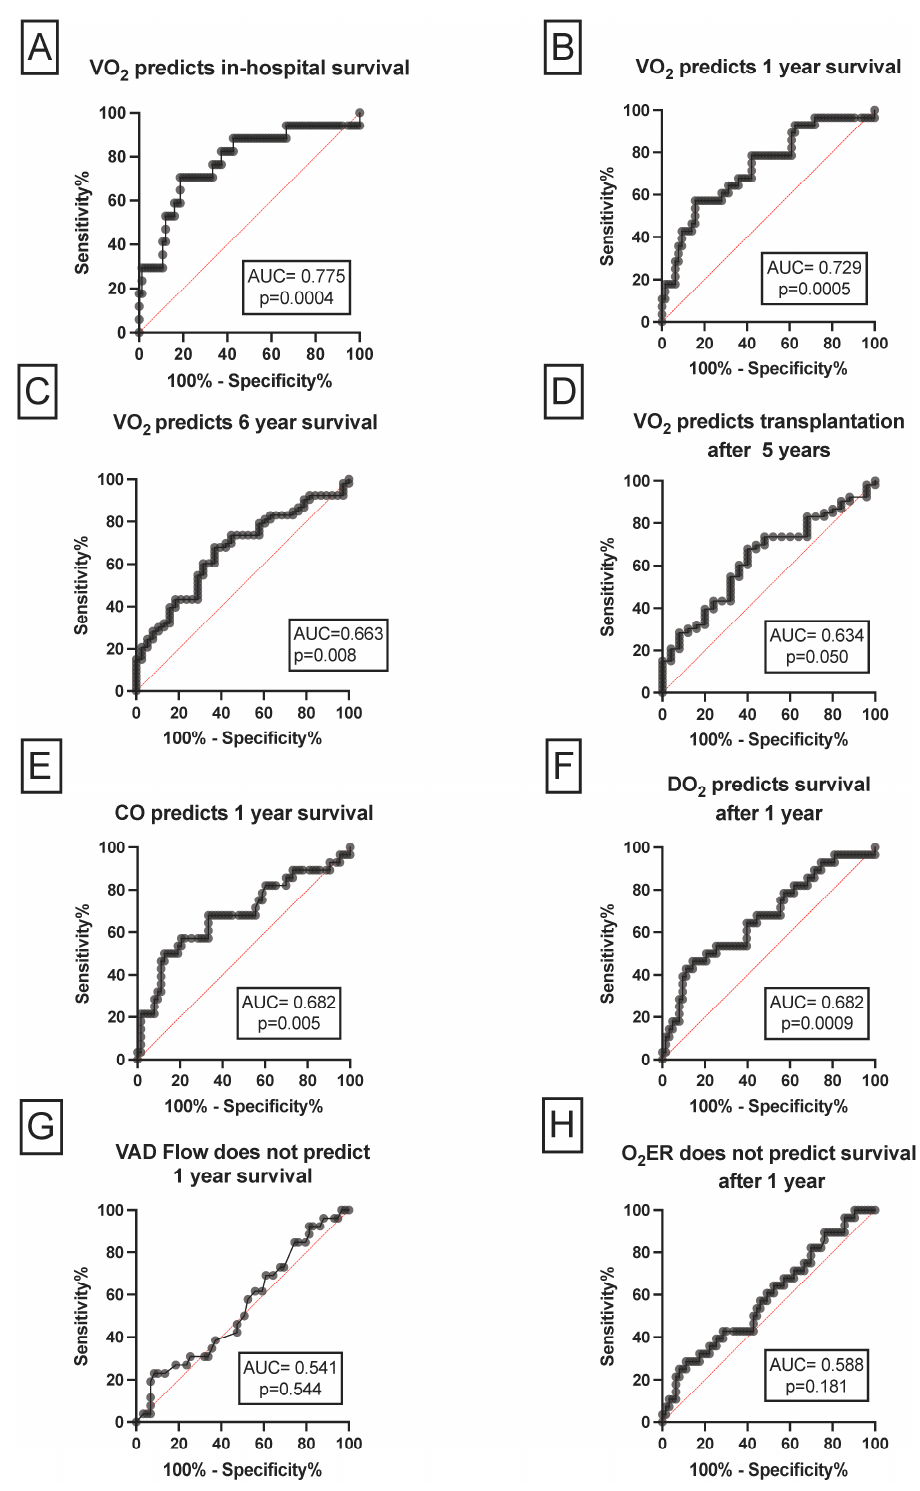
Figure 3. The association of VO 2 , CO and DO 2 and short- and long-term outcomes. Elevated VO 2 predicted in-hospital, 1-year and 6-year survival and successful transplantation within 5 years ( A – D ). Increased CO and DO 2 levels predicted 1-year survival ( E , F ). Increased VAD flow and O 2 ER did not predict 1-year survival ( G , H ). AUC, area under the curve, CO, cardiac output; VAD ventricular assist device; VO 2 , oxygen consumption.